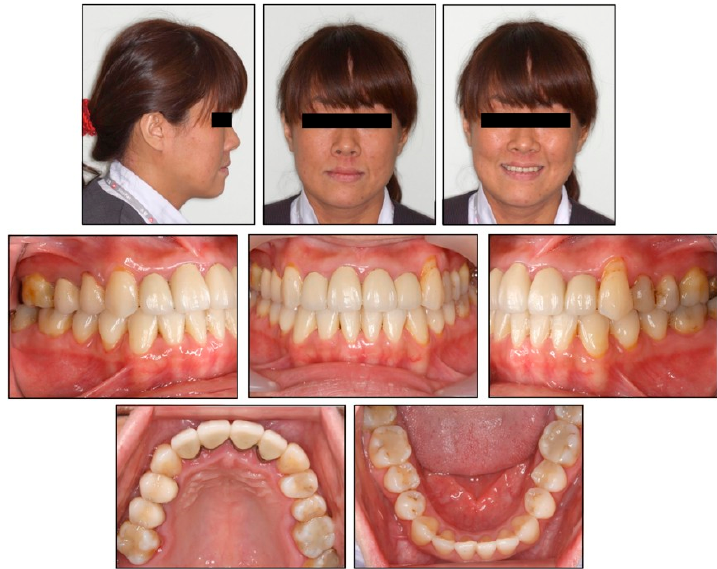
Figure 16. Case 2, Follow-up records after 8 years and 3 months.